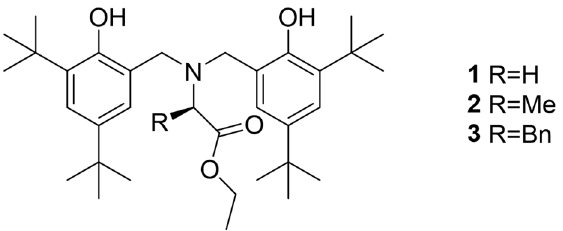
Figure 2. Structures of amino acid-derived ABP ligands 1 – 3 .